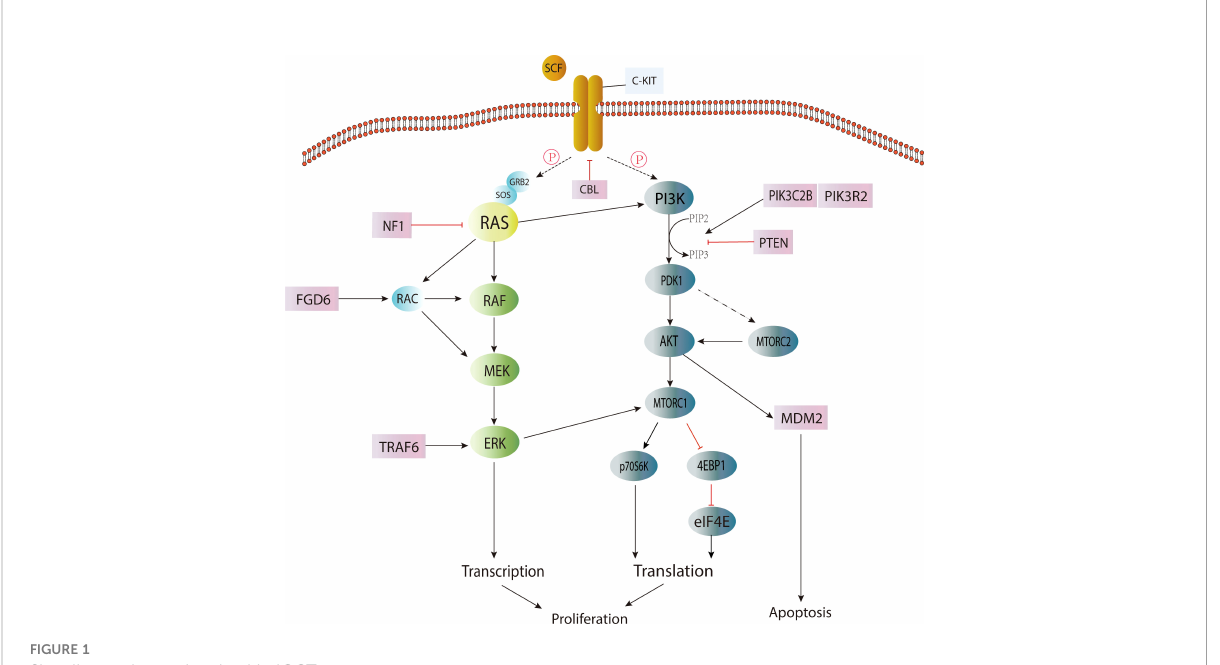
FIGURE 1 Signaling pathways involved in